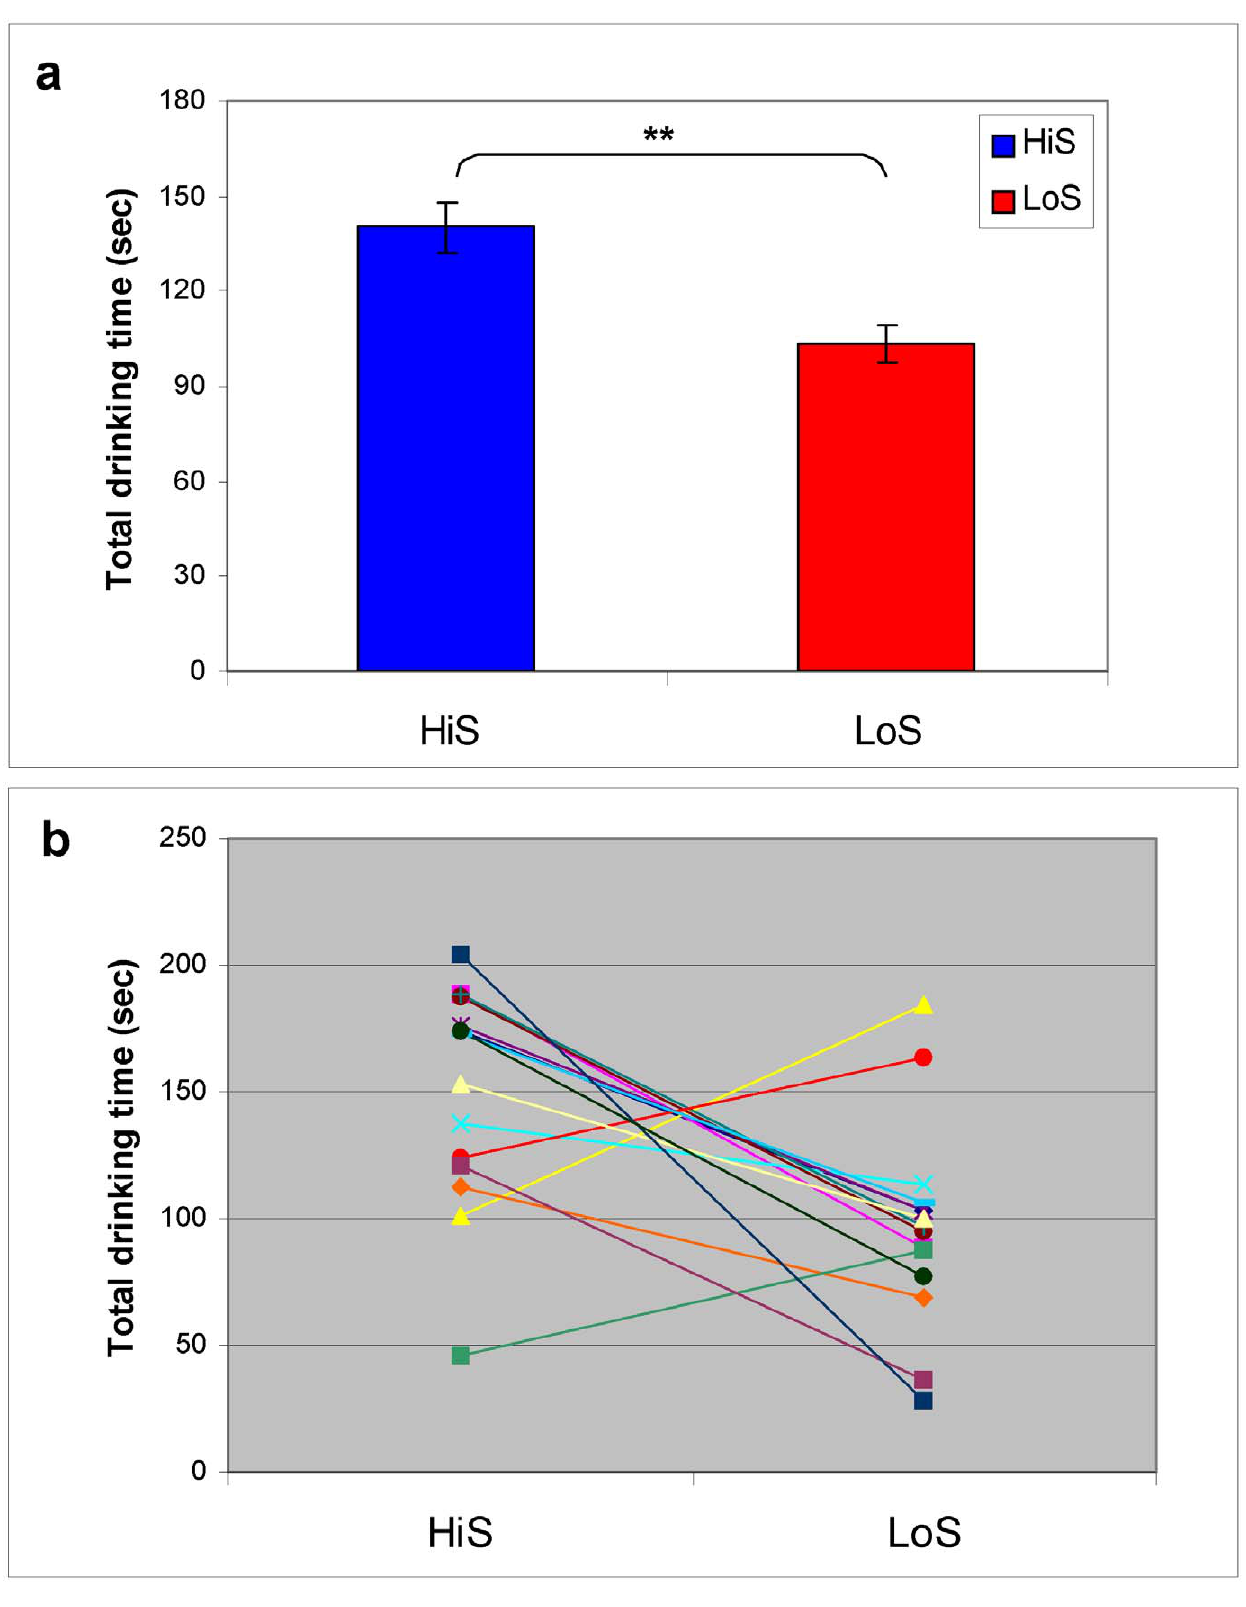
Figure 2. Total drinking time during the last competition by HiS and LoS rats. a , means (seconds 6 s.e.m.) for all 35 dyads. Drinking time was higher in HiS rats than in LoS rats ( P , .01, indicated by **). b , drinking times of individual rats in the 14 dyads (lines connect partners) meeting criteria for a ‘‘very strong’’ dominant-subordinate relationship (see text for criteria). The HiS rat was dominant in 11 of the 14 dyads.